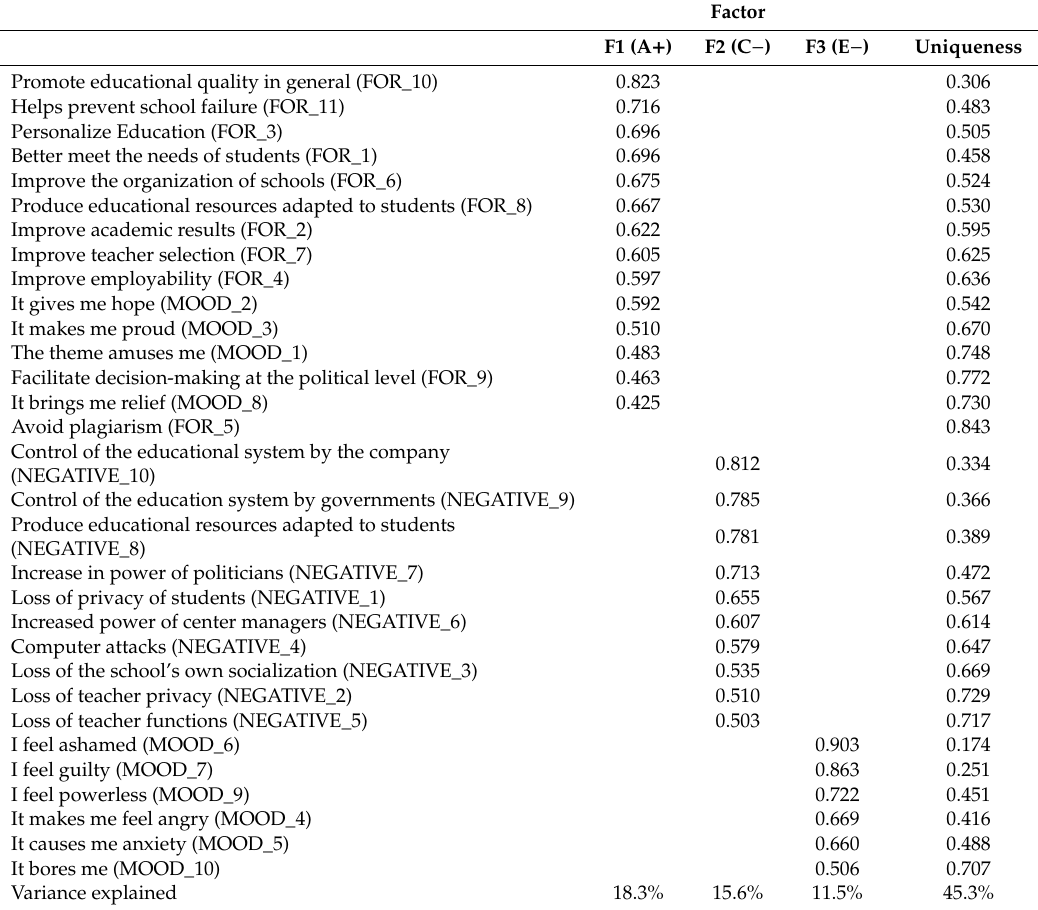
Table 1. Factor loads.